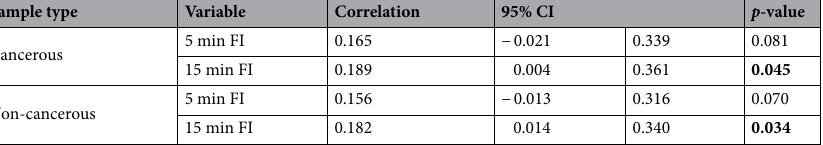
Table 1. Correlations between FIs of clinical samples and ambient temperature. FI, fluorescence increase; CI, confidence interval. Significant values are in bold.